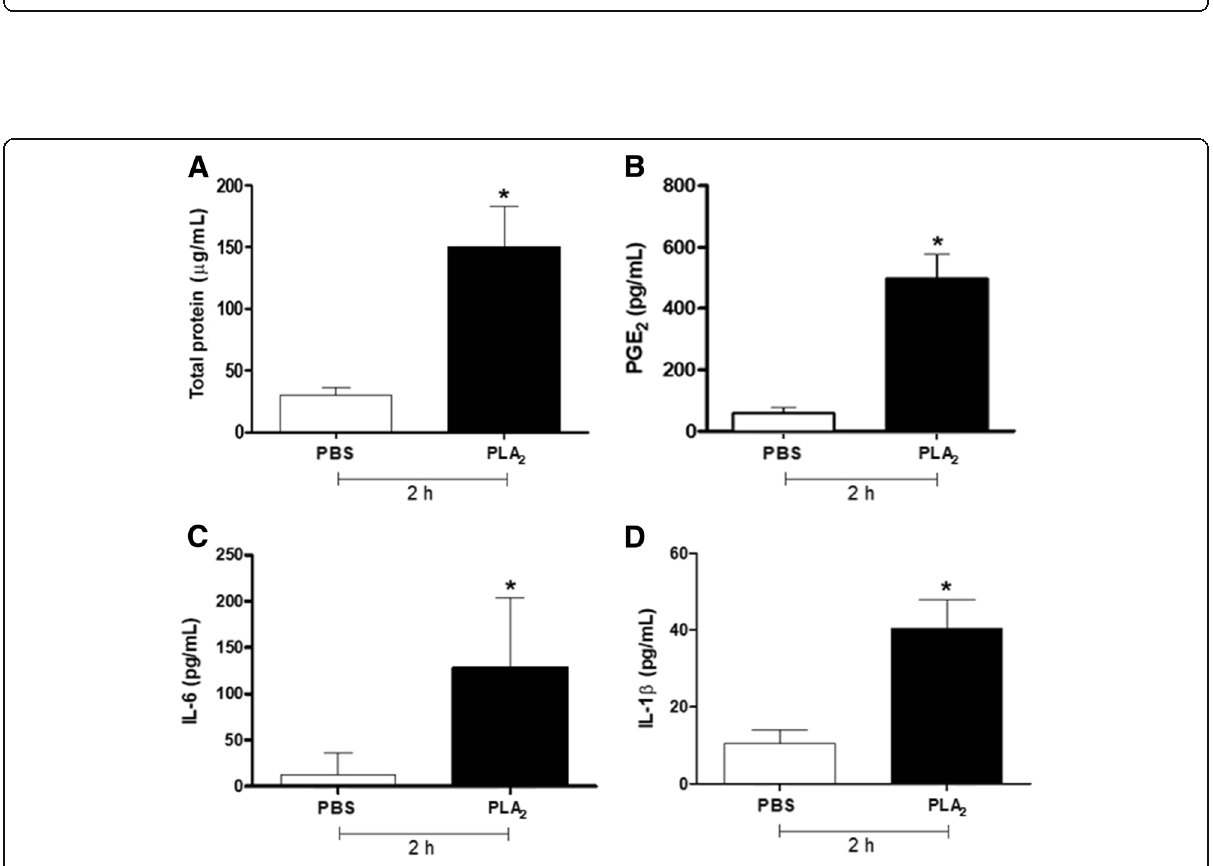
Fig. 9 Increased levels of total proteins and inflammatory mediators induced by BJ-PLA 2 -I in mice. The cell-free supernatants from the peritoneal exudate of mice stimulated for 2 h with BJ-PLA 2 -I (10 μ g/mL) were used for the quantification of total proteins ( a ), PGE 2 ( b ), IL-6 ( c ) and IL-1 β ( d ). Results were expressed as means ± SD ( n = 5) of two independent experiments. * p < 0.05 compared to the control group